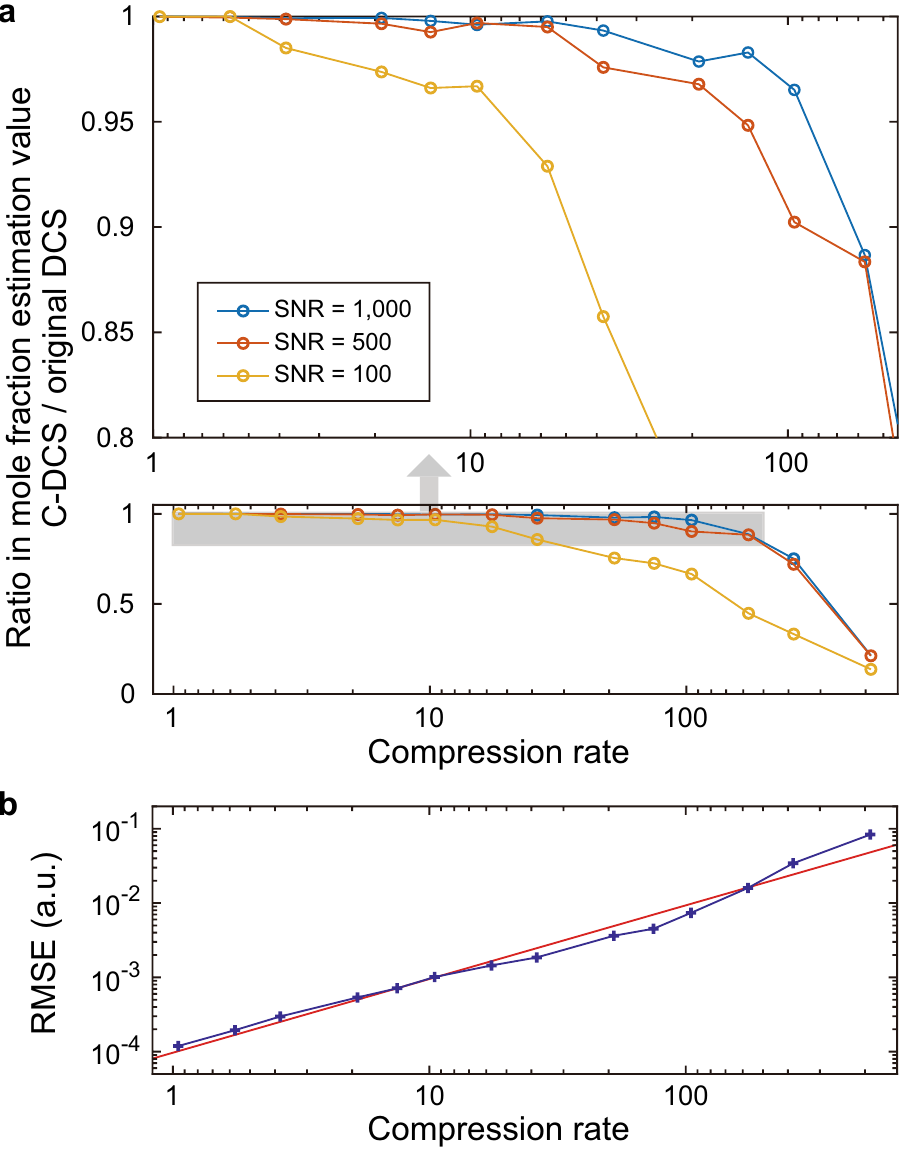
Figure 3. Mole fraction estimation from simulated spectra. ( a ) Ratio in mole fraction estimation value of C-DCS and original DCS with different compression rates. Blue, Red, and Yellow data show the results with different SNR. ( b ) Root-mean-squared error (RMSE) of the spectral points for each compression rate. The fitting (red line) shows that RMSE is proportional to (compression rate) 0.93